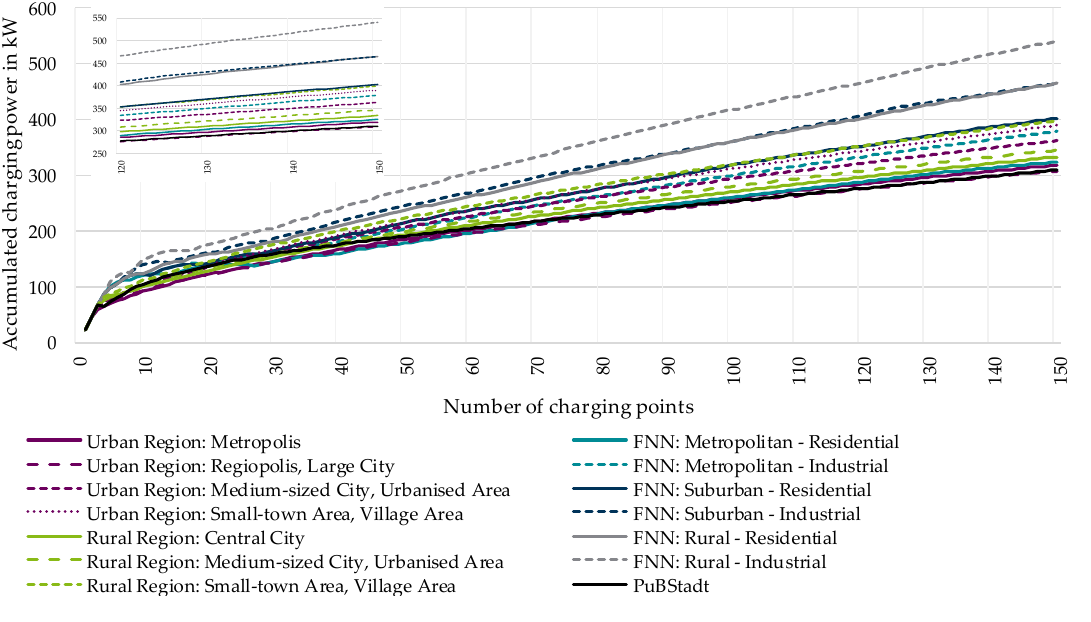
Figure 26. Accumulated charging power (ordinate) for 22 kW charging power with seven different area types, six area types according to FNN and the results from PuBStadt for 150 charging points.